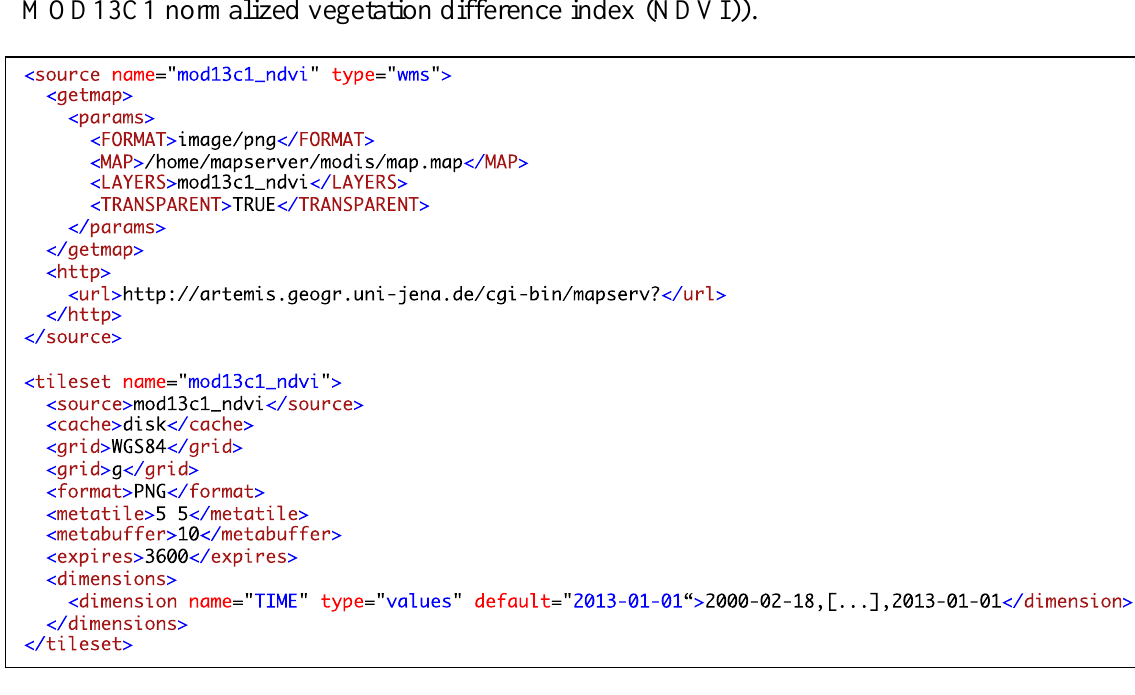
Figure 7. MapCache configuration XML: source and tileset layer properties (e.g., for MOD13C1 normalized vegetation difference index